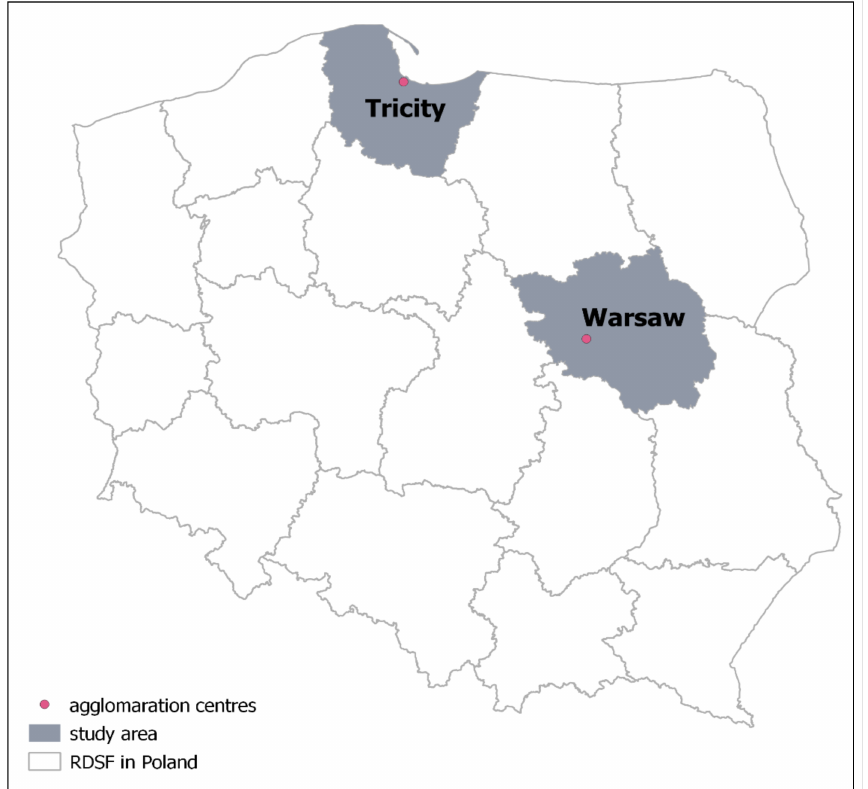
Figure 1. Location of Warsaw and Tricity on the background of the organisational divisions of state forests in